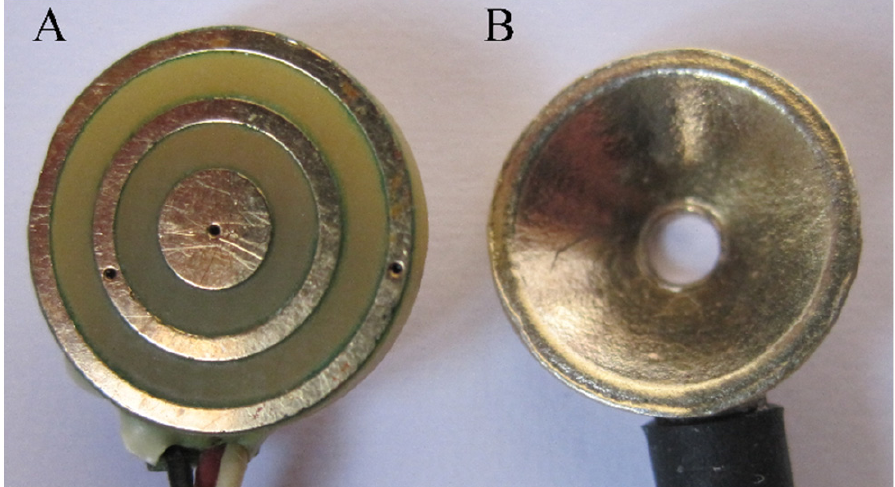
Figure 1. Tripolar concentric ring electrode ( A ) and conventional disc electrode ( B ).